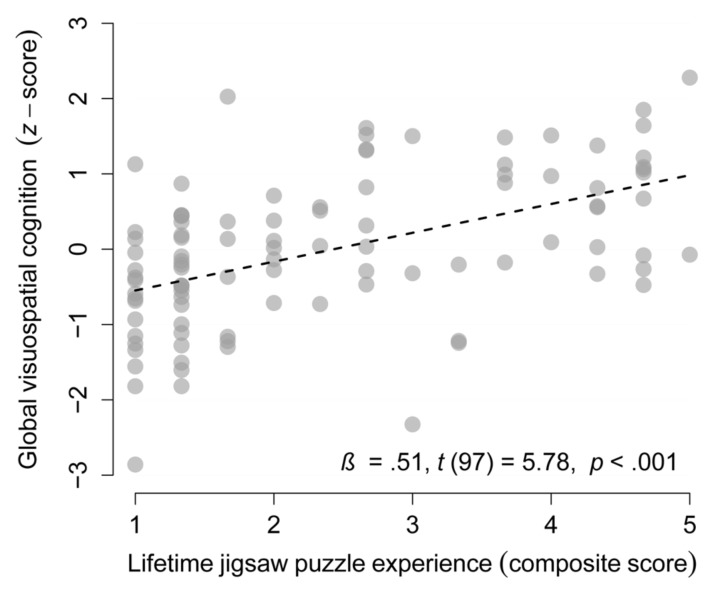
Lifetime jigsaw puzzles experience as a protective factor of cognitive aging. Association between lifetime jigsaw puzzle experience and global visuospatial cognition in the complete sample (n = 99, one missing value).